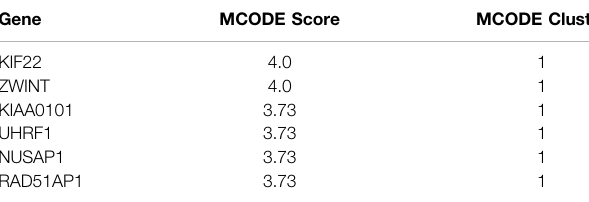
TABLE 2 | Hub genes with a high degree of